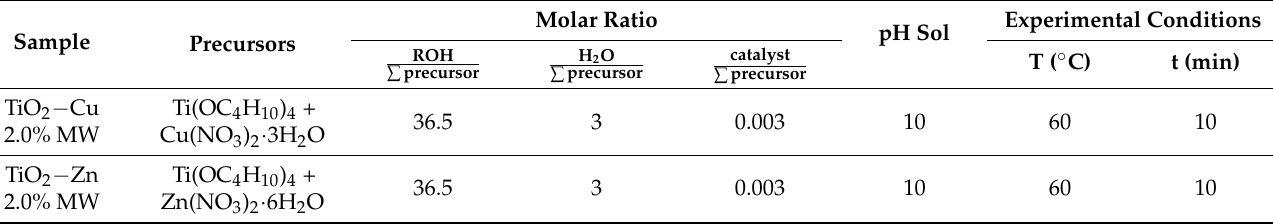
Table 6. The composition and the experimental